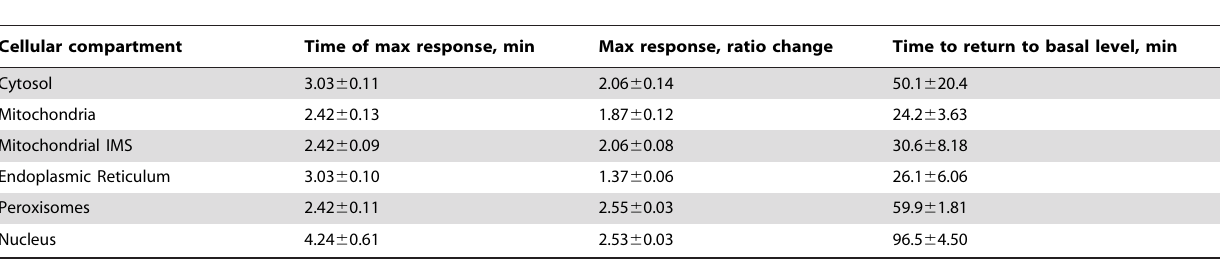
* based on the data shown in Figure 3B.